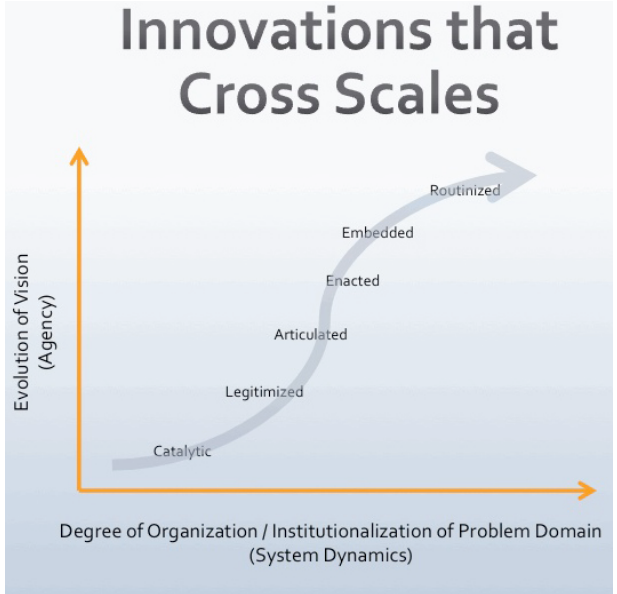
Fig. 2 . The vision as social construction